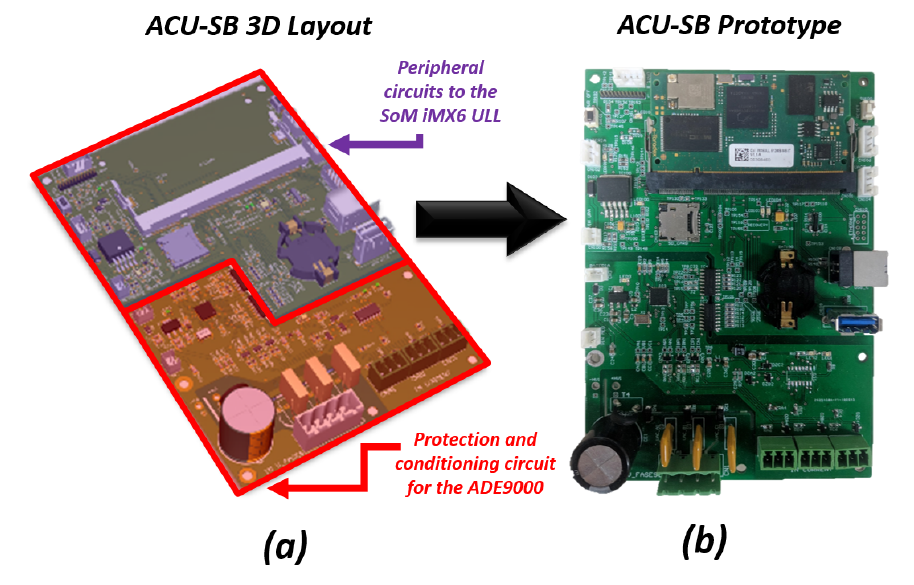
Figure 7. ACU-SB 3D layout ( a ) and prototype ( b